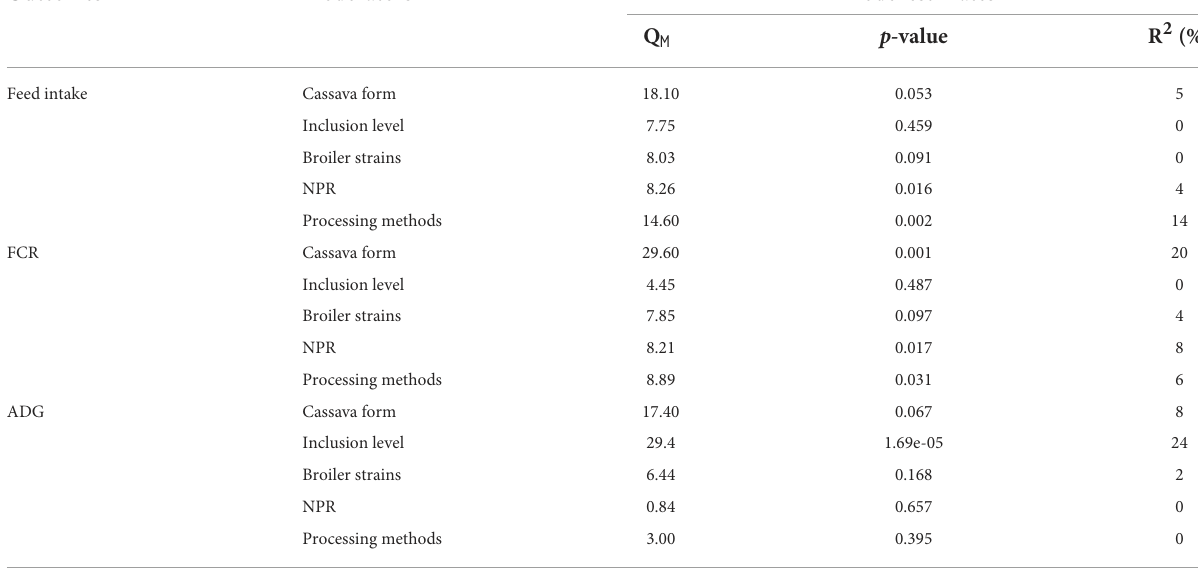
TABLE 3 Relationships between growth traits and covariates in response to cassava intervention. Outcomes Moderators